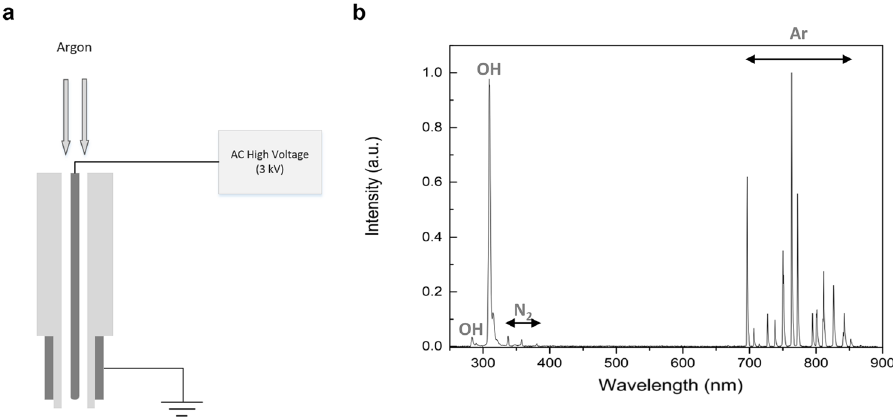
Figure 1. The brief introduction of NTP device. ( a ) Schematic of the plasma device which is a coaxial DBD (dielectric barrier discharge) jet type. ( b ) Optical emission spectrum of the Ar plasma from 200 to 900 nm. Ar lines, N 2 2 nd positive system and OH were